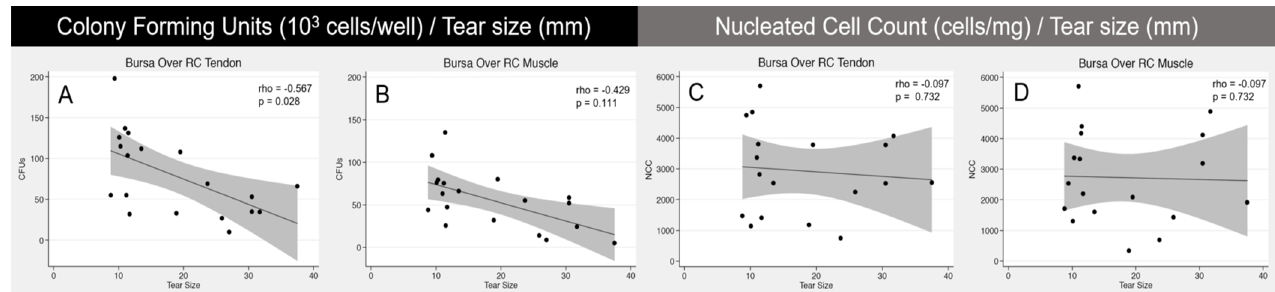
Figure 1. Scatterplot representations of Spearman’s rank correlation coefficient analysis. The left scatterplot demonstrates a significant ( p < 0.028) negative correlation between tear size and number of CFUs from the cells of the SB over the RC tendon ( A ). The right three scatterplots show no significant correlation between tear size and CFU from SAB over RC muscle ( B ) or NCC of the cells from SB over RC tendon ( C ) and muscle ( D ). Grey shading around regression line represents 95% confidence interval. Table 1. Spearman’s rank correlation coefficient analysis of the number of Colony-Forming Units (CFUs) by cells from SB over the RC tendon and muscle. Correlation analysis between the number of CFUs and patient demographics was com- pleted. While tear size was negatively correlated to the number of CFUs from both the cells from the SB over the RC tendon, there was no statistical correlation with other demographics. (* = significance p < 0.05).